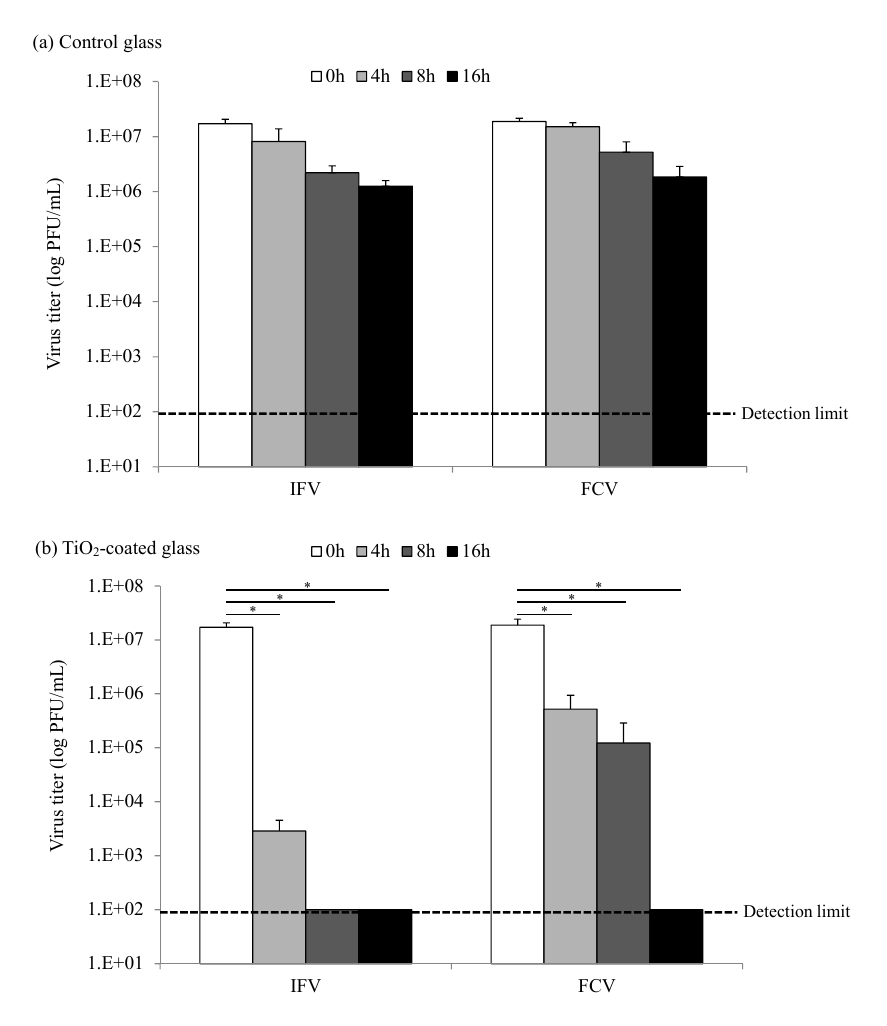
Figure 3. Photocatalytic inactivation of influenza virus (IFV) and feline calicivirus (FCV) -coated glass under black-light illumination (UVA light with ( a ) control glass or ( b ) TiO 2 intensity of 0.1 mW/cm 2 ). The data shown in the figure are the average values of three experiments. Error bars: standard deviations of three replicate experiments. * p < 0.001, 4 h, 8 h, 16 h vs . 0 h exposed to 0.1 mW/cm 2